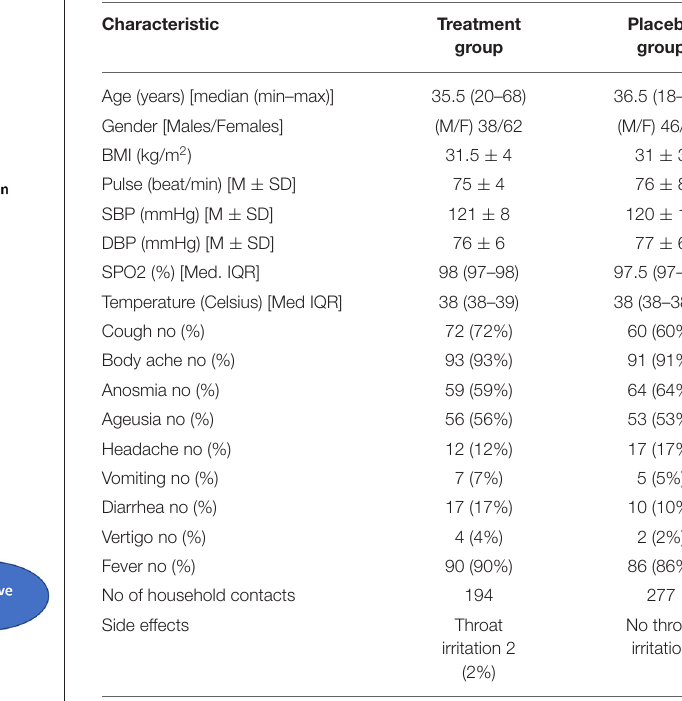
TABLE 1 | Patient characteristics and clinical symptoms and